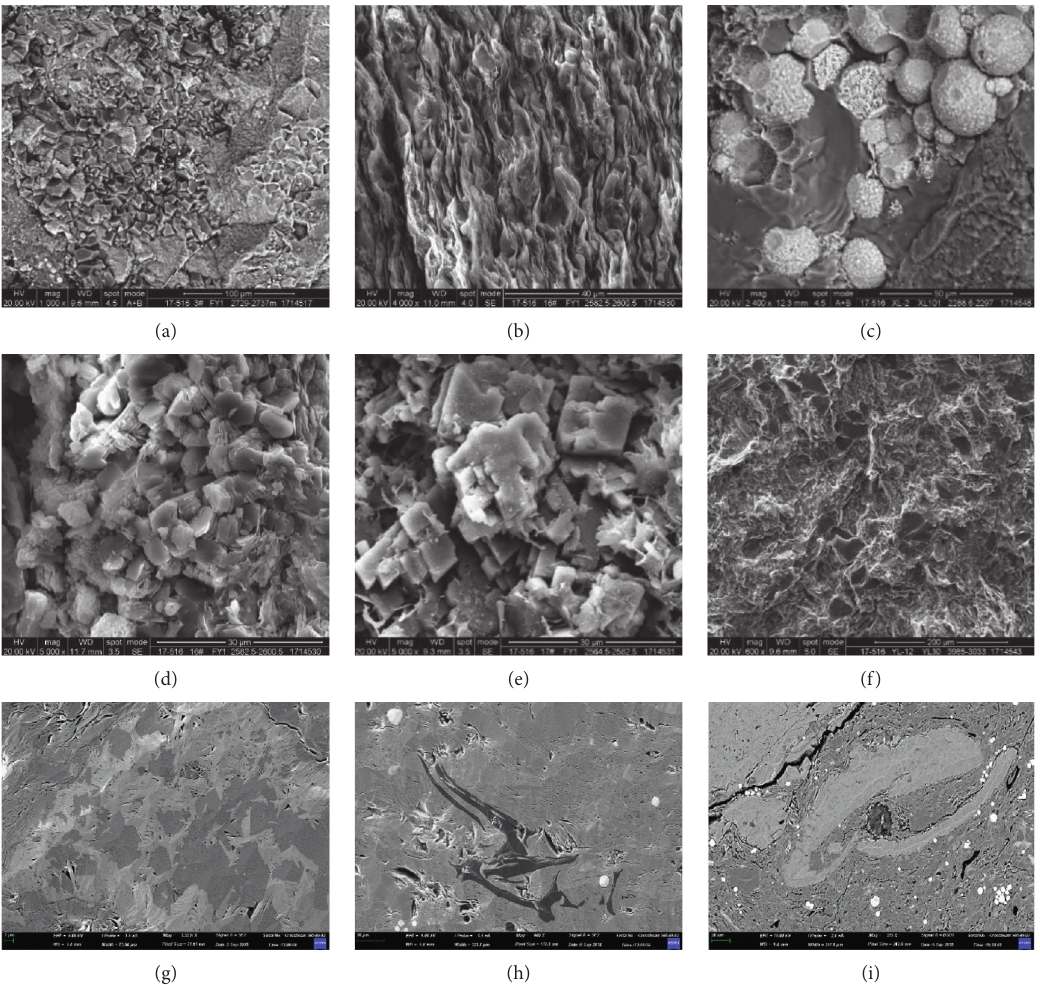
Figure 8: The microscopic characteristics of fine-grained sedimentary rocks in the Da’anzhai Member of the Jurassic in the Sichuan Basin. (a) Silicification of the shell in shale, East-1 Well, 2735.2m. (b) Shale, illite arranged in shale orientation and micro-pore, East-1 Well, 2592.6m. (c) Authigenic siliceous and authigenic pyrite aggregates, East-1 Well, 2697m. (d) Kaolinite microcrystals in shale pores, East-1 Well, 2592.6m. (e) Calcite crystals and dissolution, illite and calcite alternate, East-1 Well, 2582.3m. (f) Shale mechanically deposited quartz particles, strong compaction, North-2 Well, 3992.2m. (g) Transformation of autogenic quartz crystals and clay minerals and inorganic micropores, North-1 Well, 3935.9m. (h) Mixed layer clay-illite and organic matter, North-1 Well, 3864.9m. (i) Shell, organic matter and clay and inorganic micropores, North-1 Well, 3938.07m. All photos are SEM photo, the last three are samples prepared by argon ion